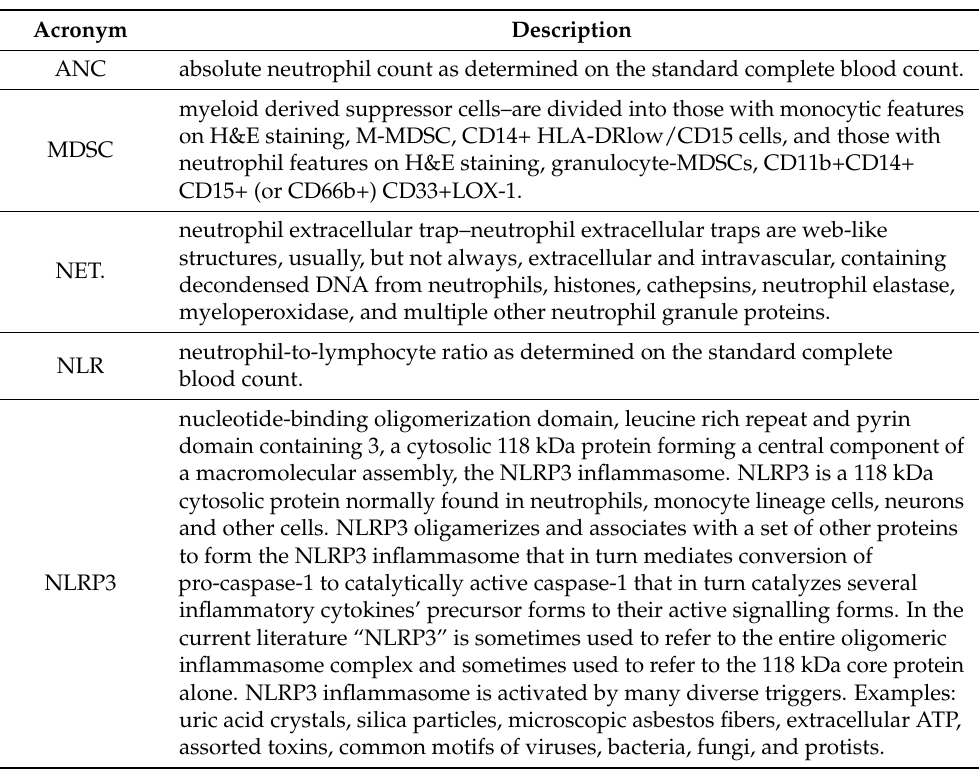
Table 2. Neutrophil related interacting elements that are currently recognized as contributing to malignant growth. For references see the corresponding main text